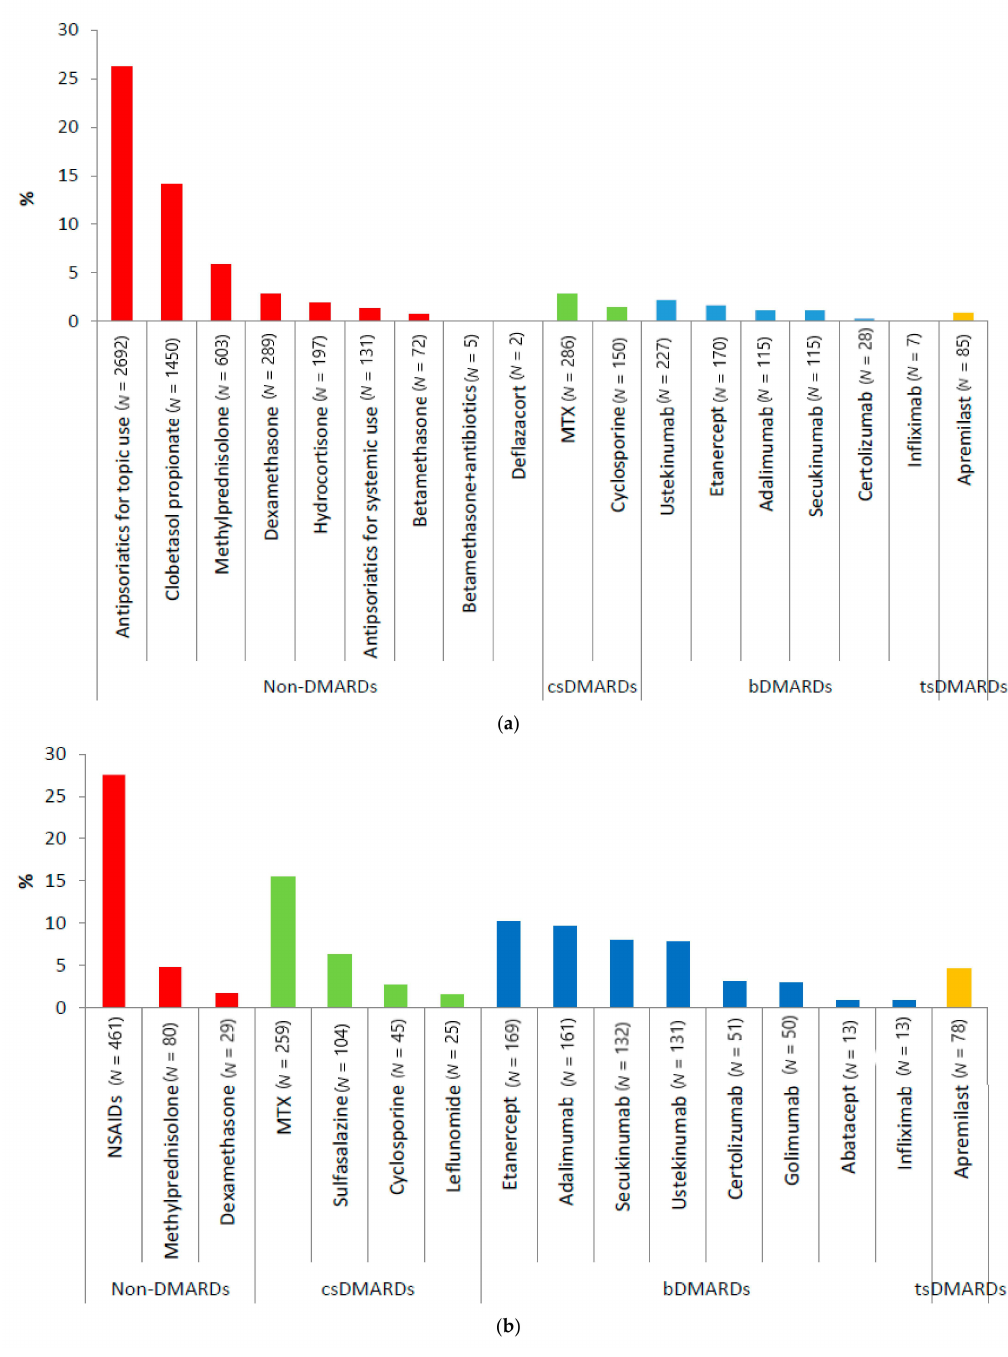
Figure 3. Distribution (%) of different compounds by pharmacological treatment lines in PsO ( a ) and PsA ( b ) patients in the Caserta LHU during the years 2016–2018. Legend: bDMARD, Biological Disease-Modifying Anti-rheumatic Drugs; csDMARD, Conventional synthetic Disease-Modifying Anti-rheumatic Drugs; DMARD: Disease-Modifying Anti-rheumatic Drugs; MTX, methotrexate; NSAIDs, nonsteroidal anti-inflammatory drugs; PsA, psoriatic arthritis; PsO, psoriasis; tsD- MARD: Targeted Synthetic Disease-Modifying Anti-rheumatic Drugs. Note: Only PsO/PsA patients with at least 6 months post-Index continuous enrollment in their database were included in this